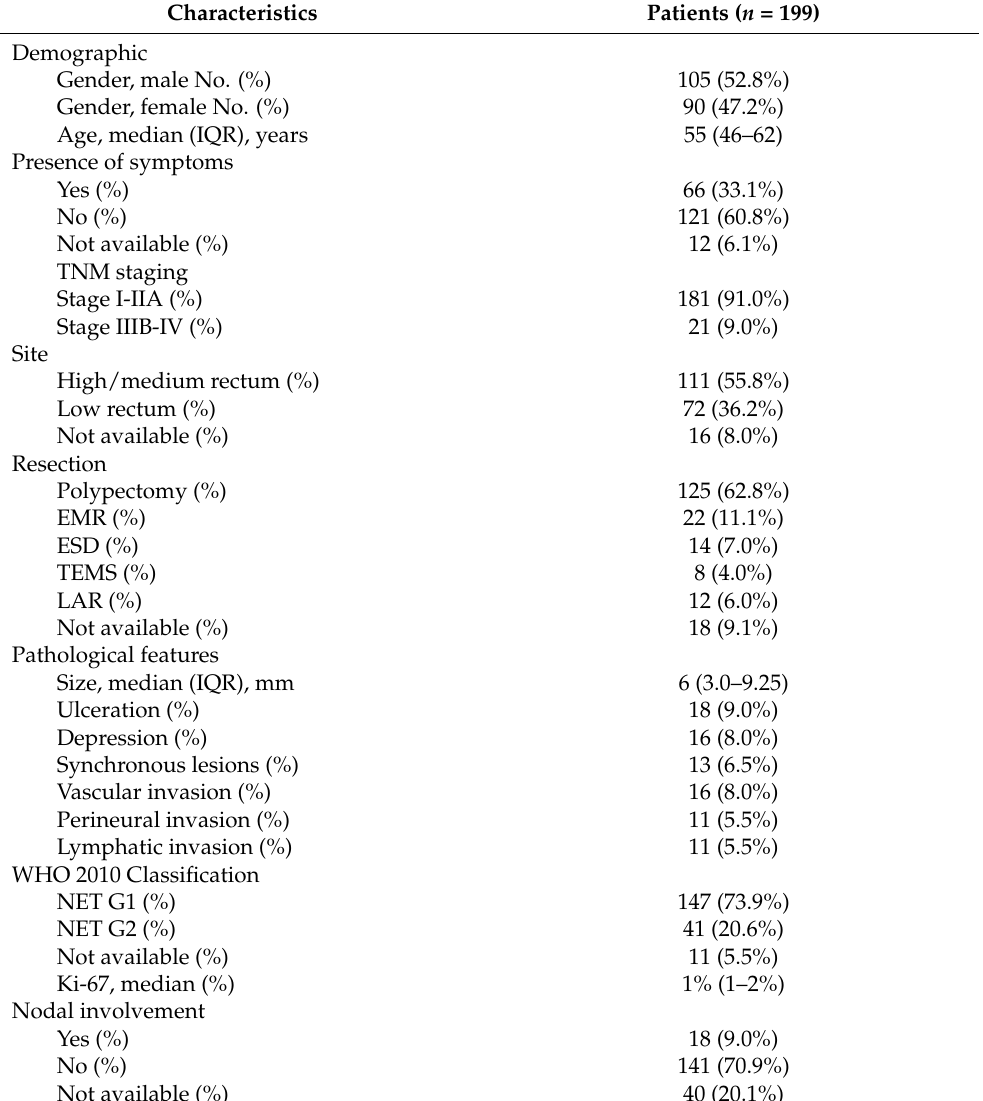
Table 1. Baseline characteristics of the study